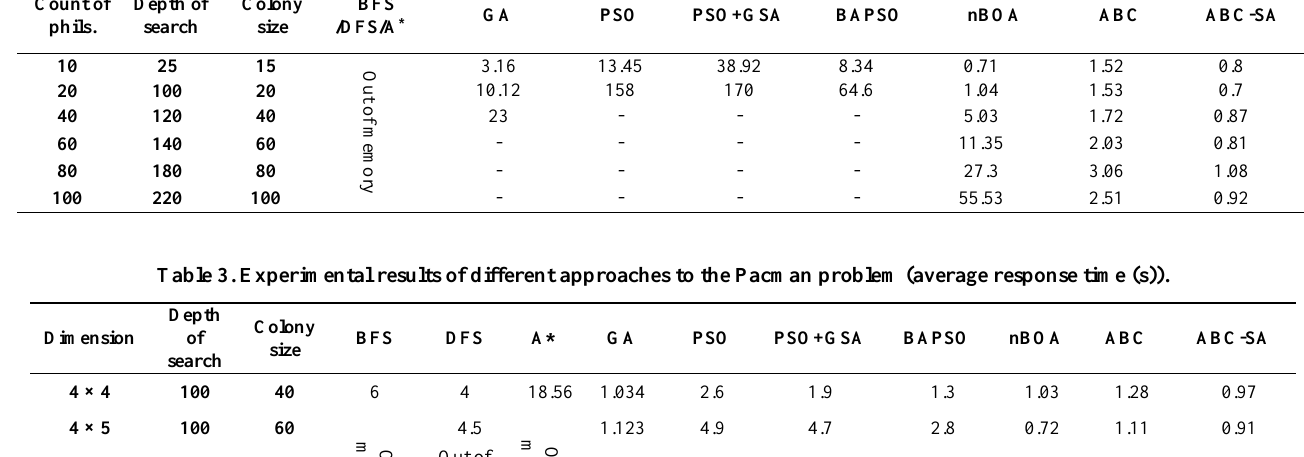
Table 2. Experimental results of different approaches to the dining philosophers problem (average response time (s)). Count of phils.